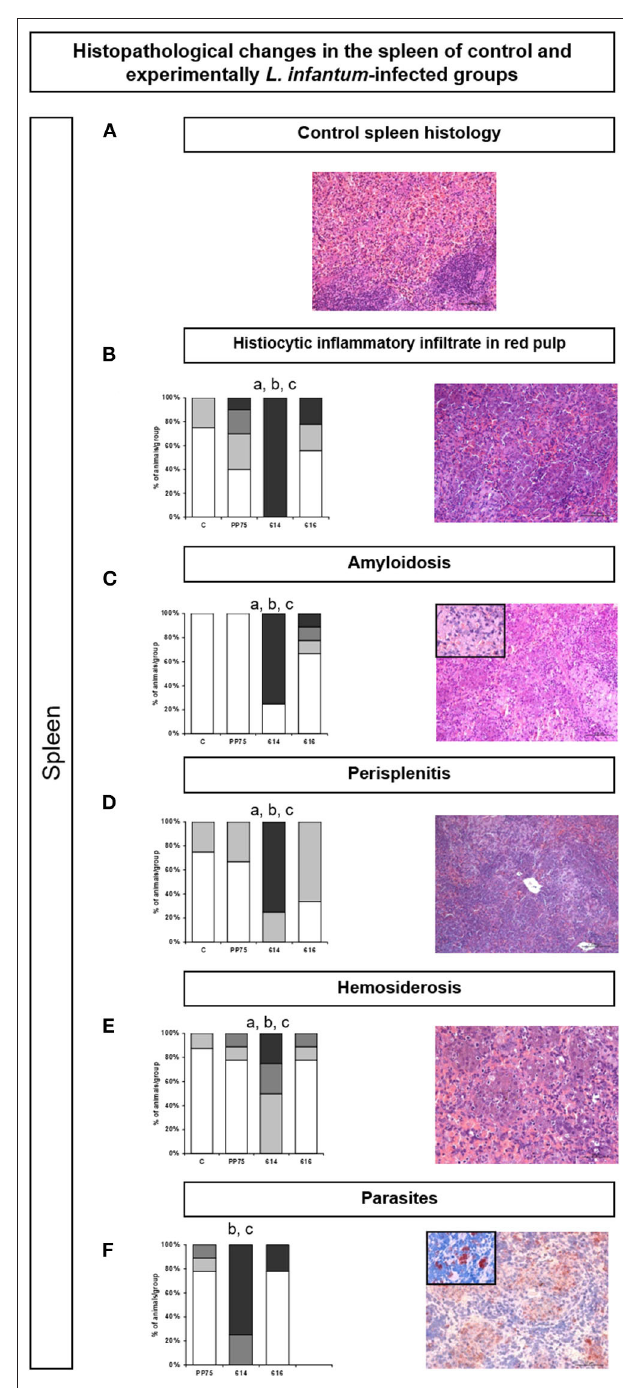
FIGURE 5 | Frequency and histopathological changes in the spleen of control group and experimentally L. infantum- infected groups (reference strain: PP75; and wild strains: 614 and 616). The intensity of histopathological changes was graded as absent (–, ), mild ( + , ), moderate ( ++ , ), and severe ( + + + , ). The histopathology analysis was performed for histiocytic inflammatory infiltrate in the red pulp (B) , amyloidosis (C) , perisplenitis (D) , hemosiderosis e , and parasitism (F) . Images obtained from optical microscopy illustrate each analysis of HE-stained (A–E) and immunohistochemistry